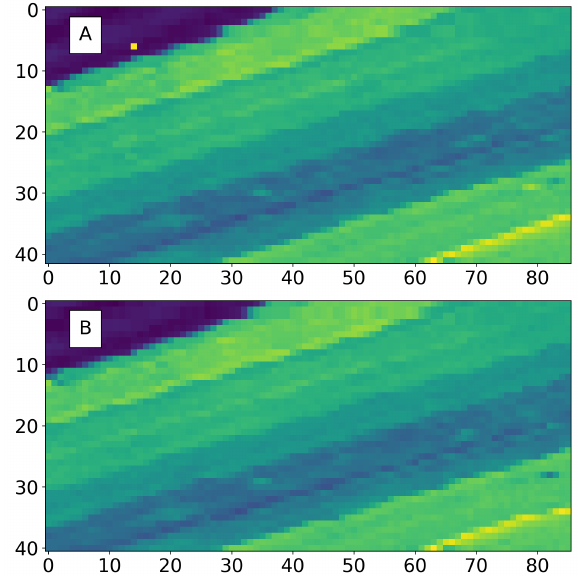
Figure 4: Salinas test and training data. Images A and B repre- sent Salina’s frame number 144 (wavelength 1890 nm) after the slicing. The dataset was divided horizontally, top-down. Every other row to training data (A), every other to test data (B).